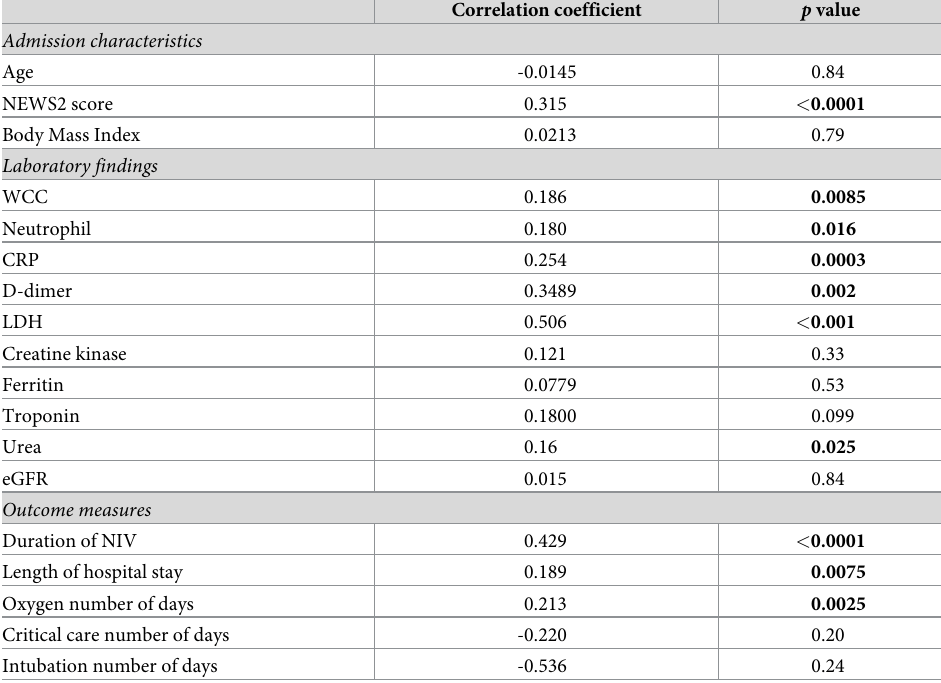
Table 3. Correlation of % shunt with clinical